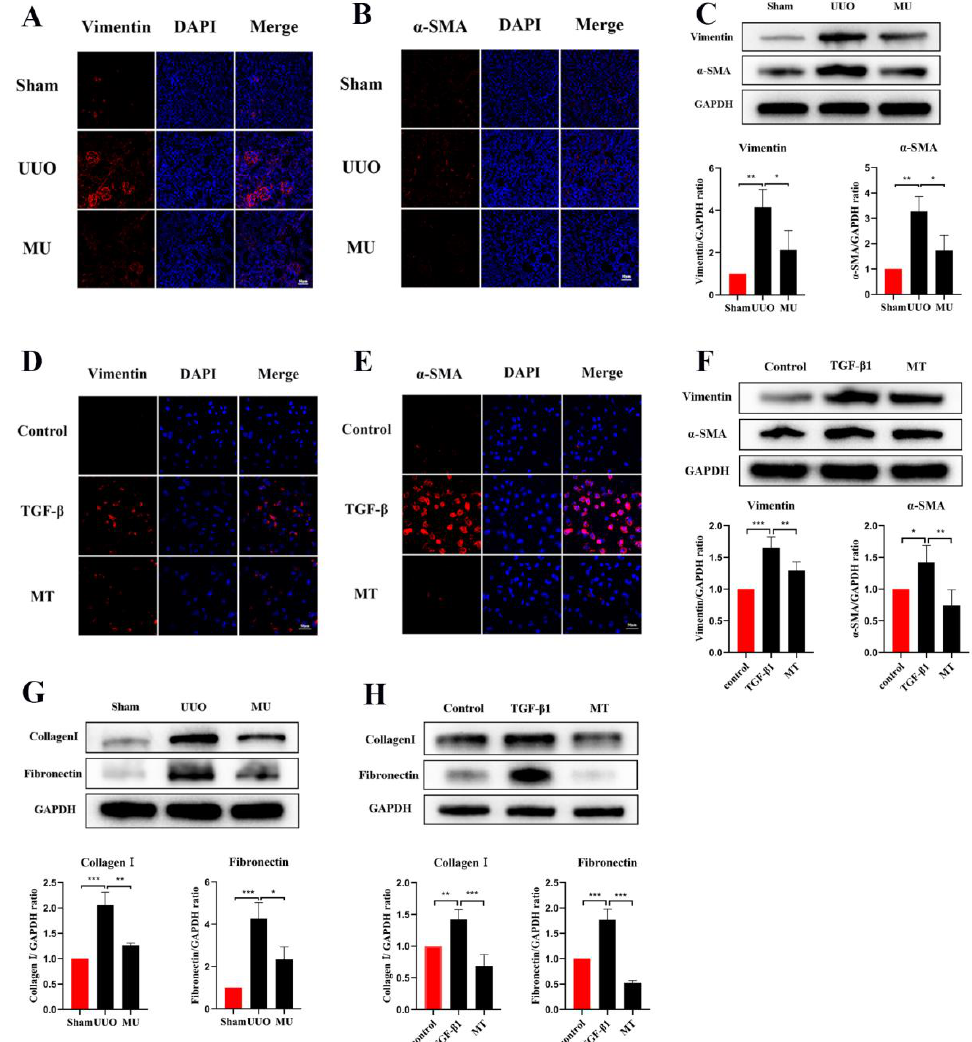
Figure 5. MK-2206 reduced myofibroblast formation and the deposition of extracellular matrix in UUO mice and TGF- β1 -induced HK-2 cells. ( A – C ) Immunofluorescence staining and Western blot analysis of Vimentin, α -SMA in kidney tissues (scale bar: 100 μm). ( D – F ) Immunofluorescence staining and Western blot analysis of Vimentin, α -SMA in HK-2 cells (scale bar: 100 μm). ( G ) Western blot was used to detect the protein expression levels of Collagen I and Fibronectin in the kidney of each group of mice. ( H ) Protein expression levels of Collagen I and Fibronectin in HK-2 cells were detected by Western blot. Protein levels were normalized with GADPH. * p < 0.05, ** p < 0.01, *** p < 0.001. MU: UUO+ MK-2206, MT: TGF- β 1 + MK-2206. 3.6. MK-2206 Inhibits the Activation of Akt/mTOR Pathway in the UUO Model To verify the ability of MK-2206 to attenuate renal fibrosis and its specific mechanism of action, we examined the phosphorylation levels of related proteins in the Akt-mTOR pathway. The results of immunohistochemistry and immunofluorescence staining revealed that UUO kidneys overexpressed phosphorylated Akt and mTOR compared to the normal kidneys, while MK-2206 effectively inhibited the phosphorylation of Akt and